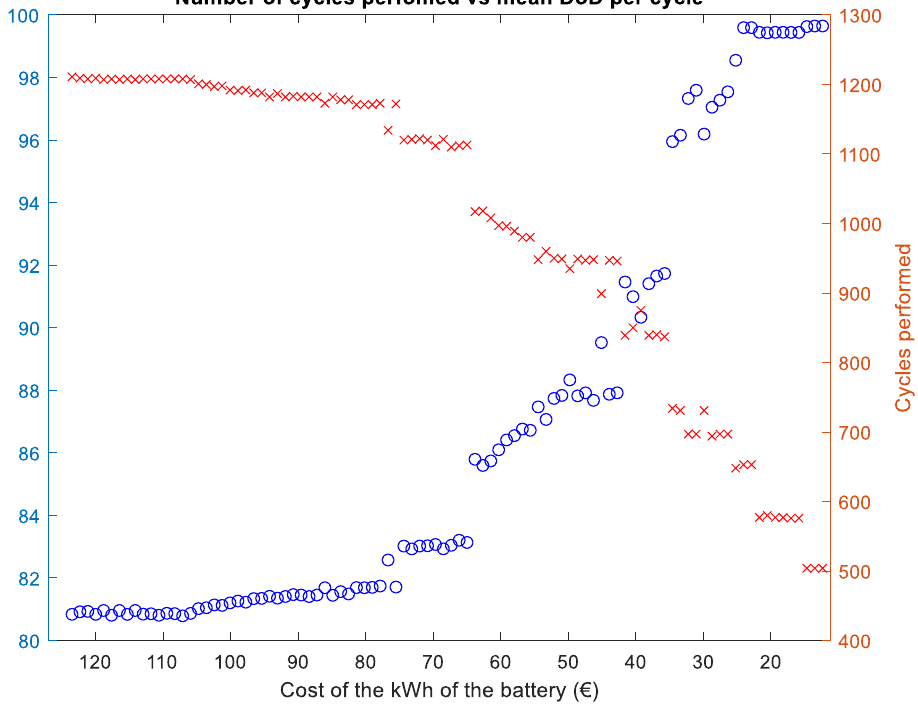
Figure 13. Performed cycles by battery, and average endured DoD along the performed cycles.